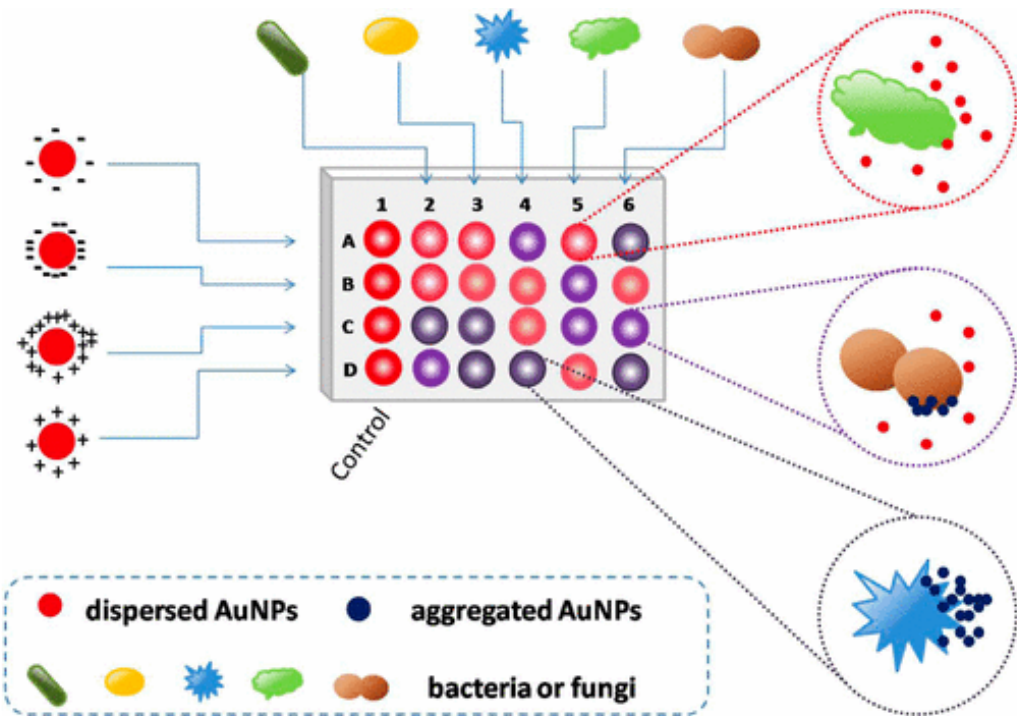
Figure 2. Schematic representation of the colorimetric nanosensor with four types of coated AuNPs. The interactions of microorganisms and AuNPs result in color changes. In the diagram, column 1 represents the blank control, and other columns show various organisms. Rows A to D represent four coated AuNPs, adapted from [80], ACS, 2017.